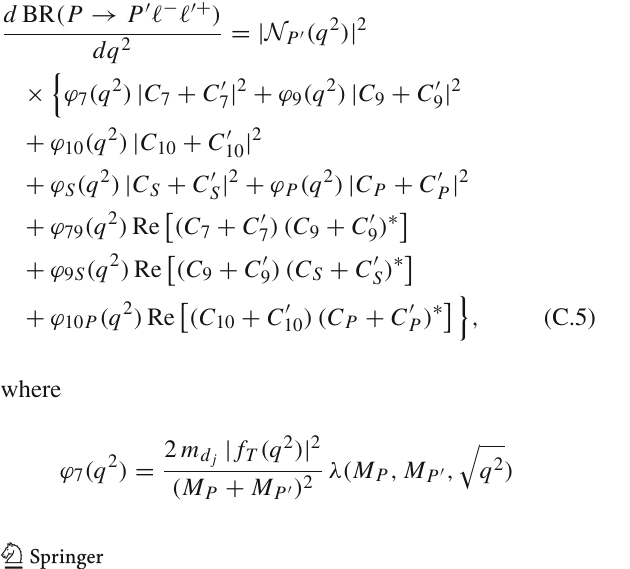
expressed in the